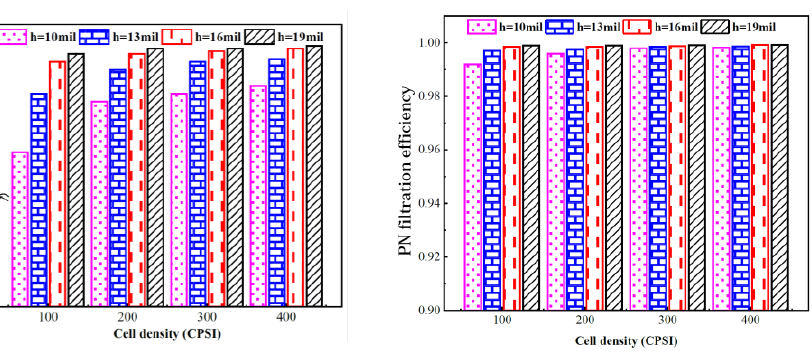
Fig. 8. Influence of the DPF cell density and wall thickness on the PM filtration efficiency under certain conditions.